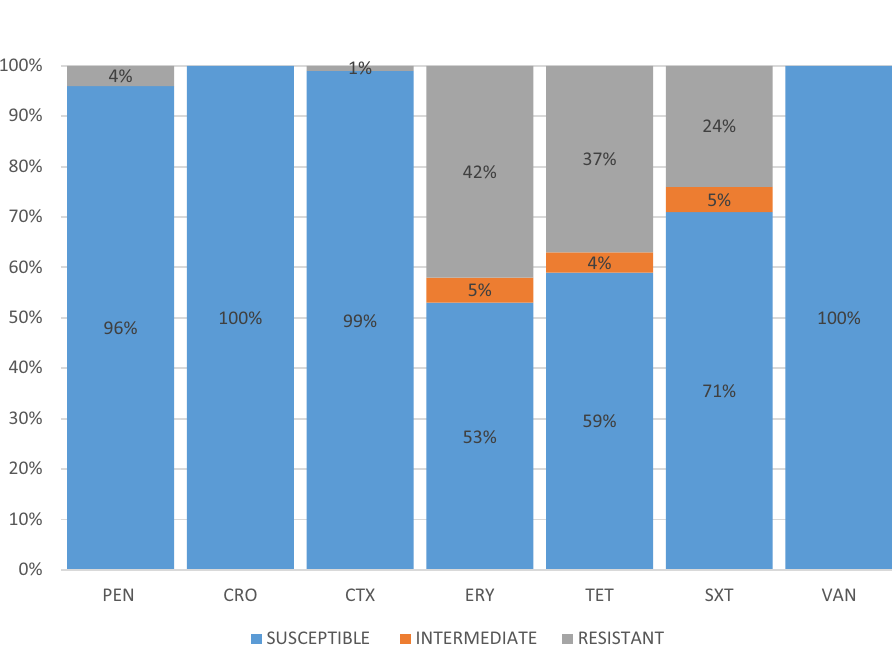
Figure 1. Antimicrobial susceptibility pattern among the collection of 100 isolates. Susceptibility test by E-test (MIC determination) for penicillin (PEN), ceftriaxone (CRO) and cefotaxime (CTX). Susceptibility test by disk diffusion for tetracycline (TET), erythromycin (ERY), trimethoprim-sulfamethoxazole (SXT) and vancomycin